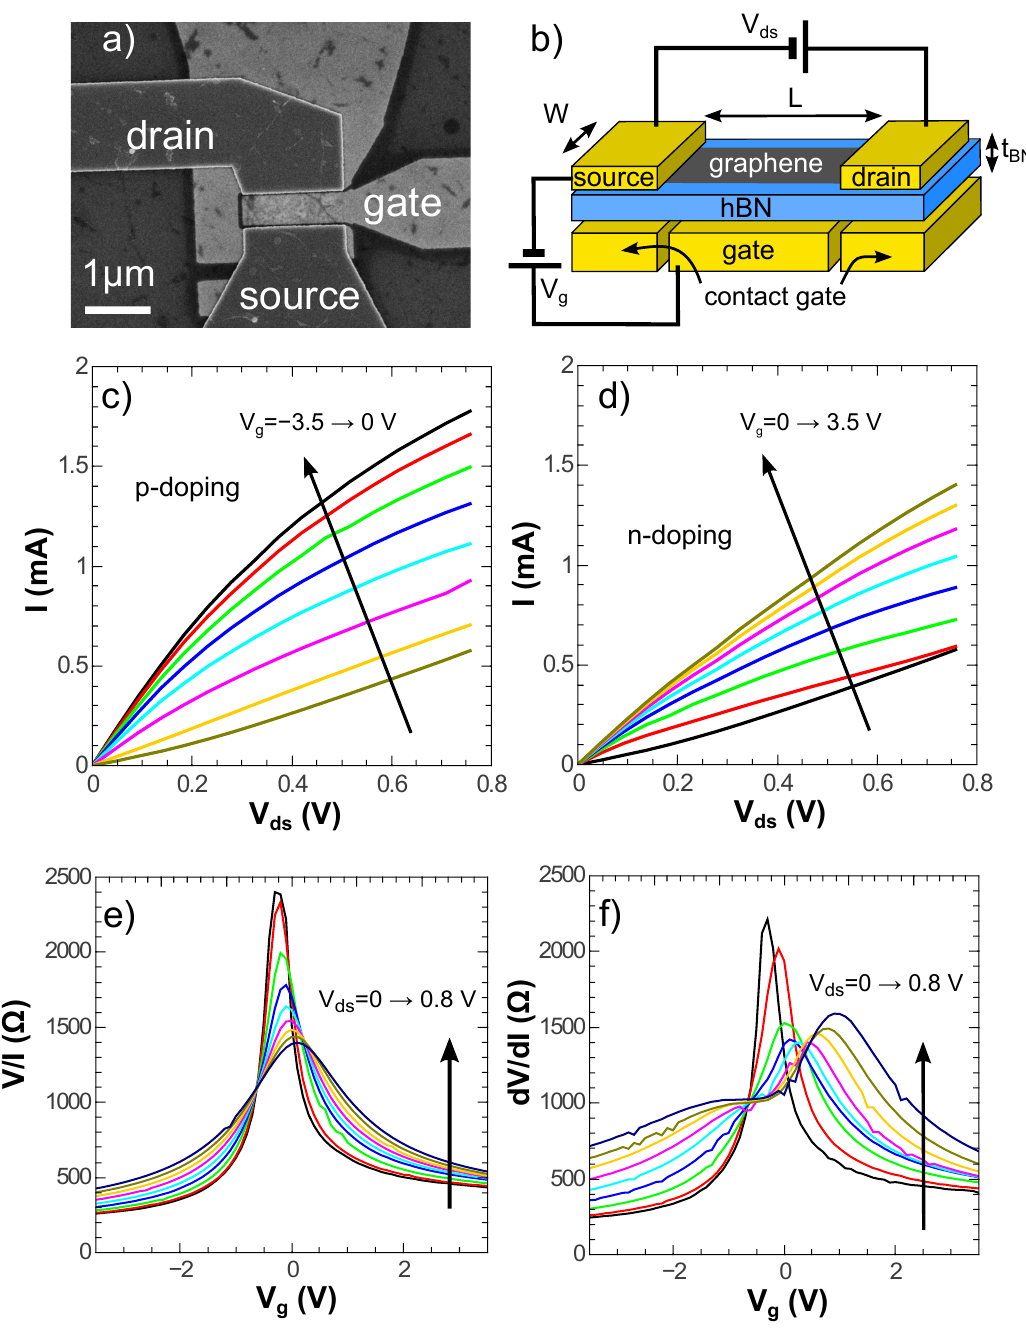
Figure 1. Low frequency field effect transistors (GFETs). ( a ) SEM image of sample-A. Note the absence of ungated area. ( b ) Electrical sketch of samples used in this study. For sample-A we have L = 500 nm, W = 1.5 µ m and t BN = 16 nm. ( c ) I–V characteristic of sample A in the p-doping regime. ( d ) I–V characteristic of sample-A in the n-doping regime. ( e ) DC resistance of sample-A. ( f ) RF small signal resistance of sample-A. The global increase of resistance with V ds is due to HPhP scattering only for negative gate voltages and both HPhP scattering and Dirac pinch-off for positive gate voltages. The resistance peak of dV ds / dI is the best working point for an RF